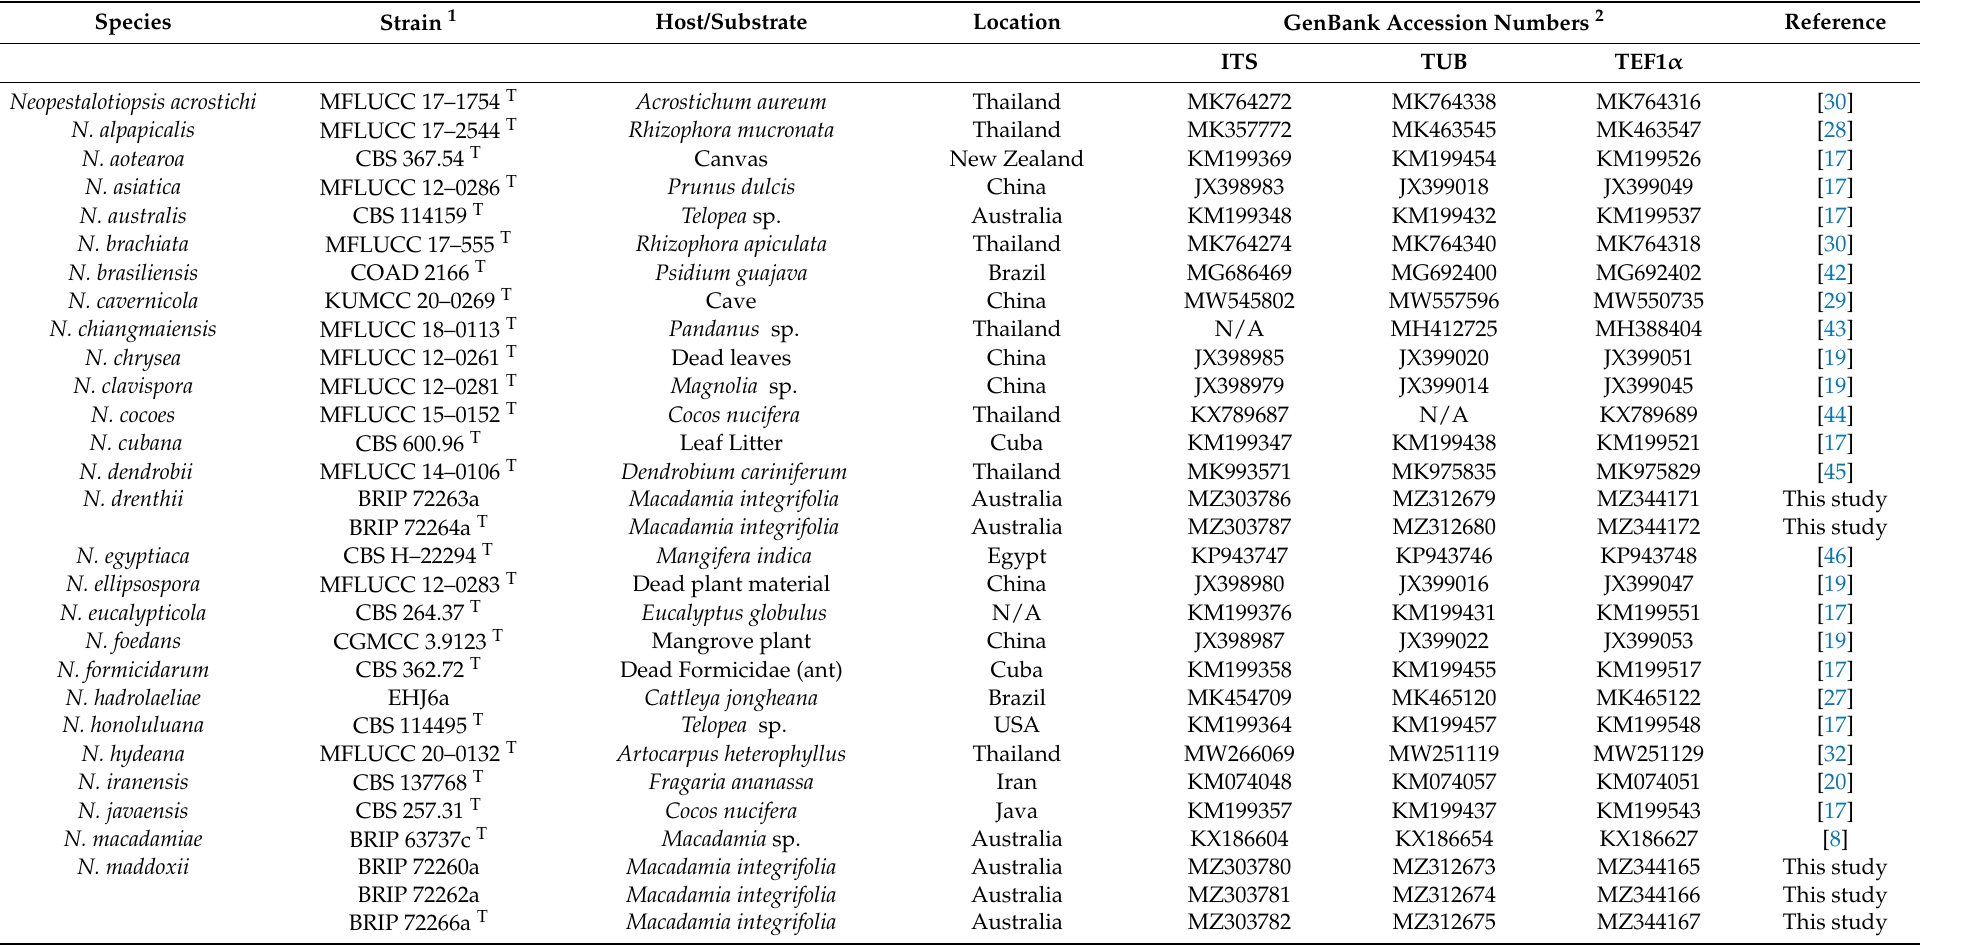
Table 1. Neopestalotiopsis species and isolates used in the phylogenetic analyses, with GenBank accession